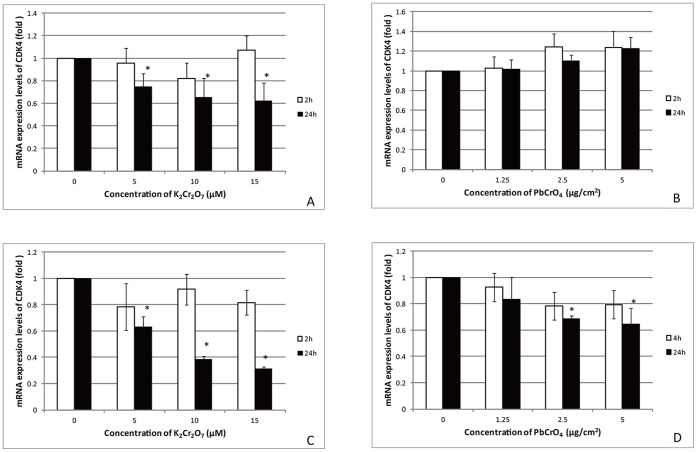
mRNA expression of CDK4 gene.A and C: mRNA expression levels (fold change) of CDK4 gene in human B lymphoblastoid cells (A) and in A549 cells (C) cells exposed to potassium dichromate at the concentrations of 0, 5 µM, 10 µM, and 15 µM for 2 hours and 24 hours. B and D: mRNA expression levels (fold change) of CDK4 gene in human B lymphoblastoid cells (B) and in A549 cells (D) cells exposed to lead chromate at the concentrations of 0, 1.25 µg/cm2, 2.5 µg/cm2, and 5.0 µg/cm2 for 4 hours and 24 hours. Hash keys above the bars: P<0.05 as compared with control; asterisks above the bars: P<0.01 as compared with control.